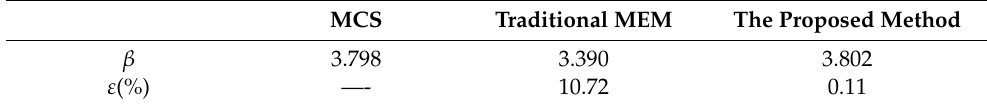
Table 5. Comparison of estimated reliability index for different approaches.